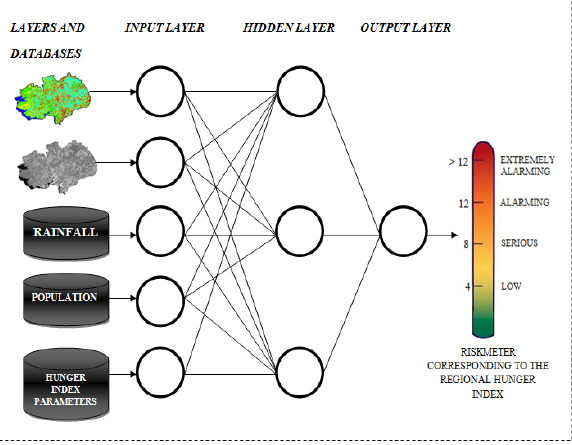
Figure 3. Network